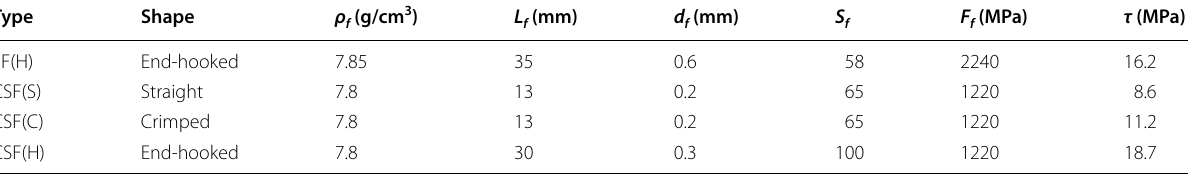
Table 2 Properties of steel